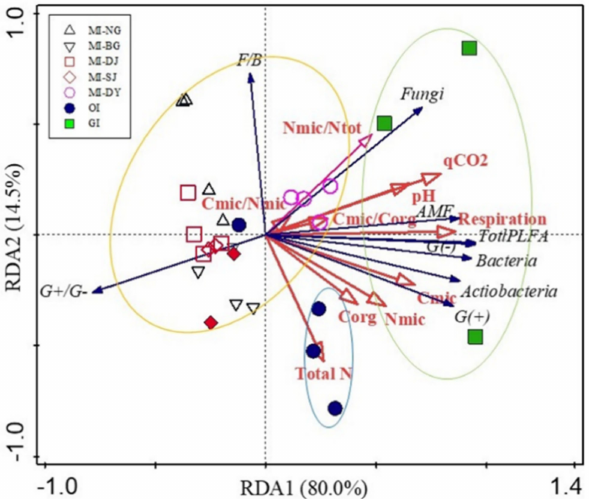
Figure 4. Redundancy analysis (RDA) of the correlations between soil parameters (chemical proper- ties and microbial biomass) and microbial communities of the different